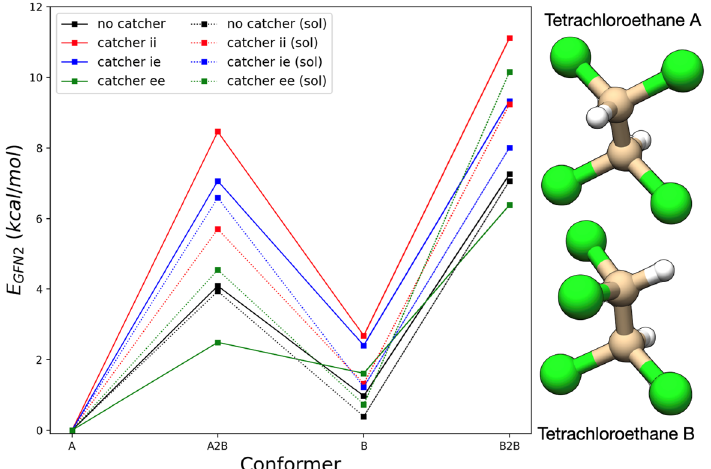
Figure 4. The energy surface of tetrachloroethane free and in between the arms of specific conform- ers of the buckycatcher according to GFN2-xTB. Relative energies are in